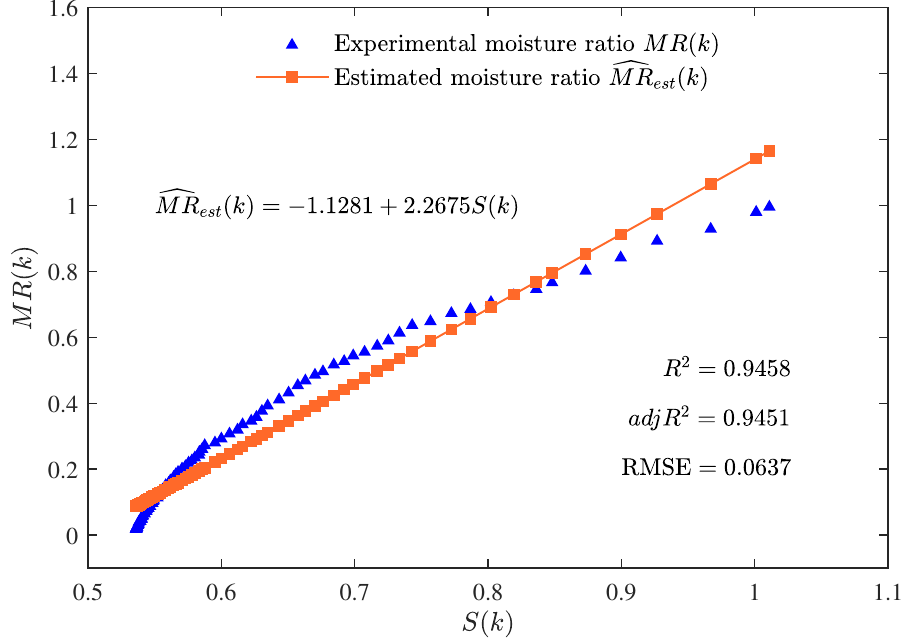
Figure 5. The estimated moisture ratio (cid:100) MR est ( k ) versus the shrinkage S ( k ) for n =